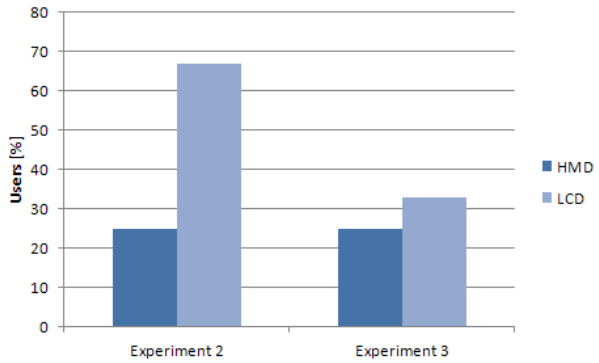
Fig. 21. Error rates in the medical procedure using both visual output devices in the second and third